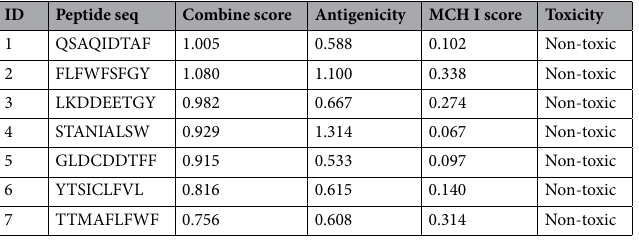
Table 2. Selected cytotoxic T-lymphocyte (CTL) epitopes for multi-epitope vaccine construction.